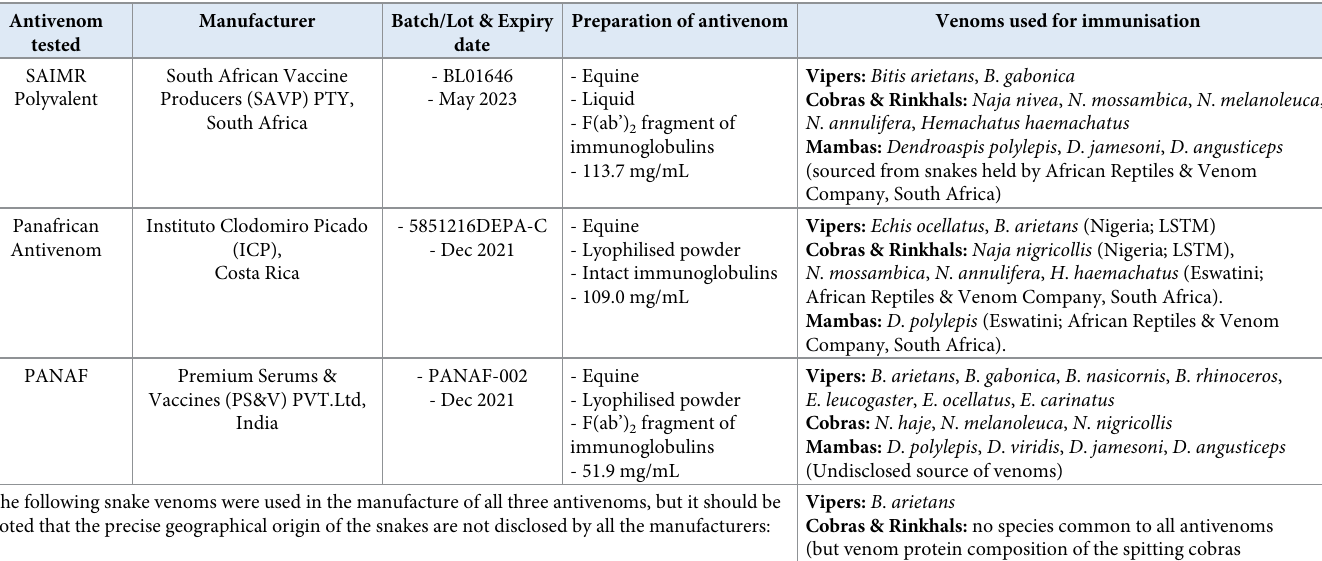
Table 1. Details of the antivenom products examined in this